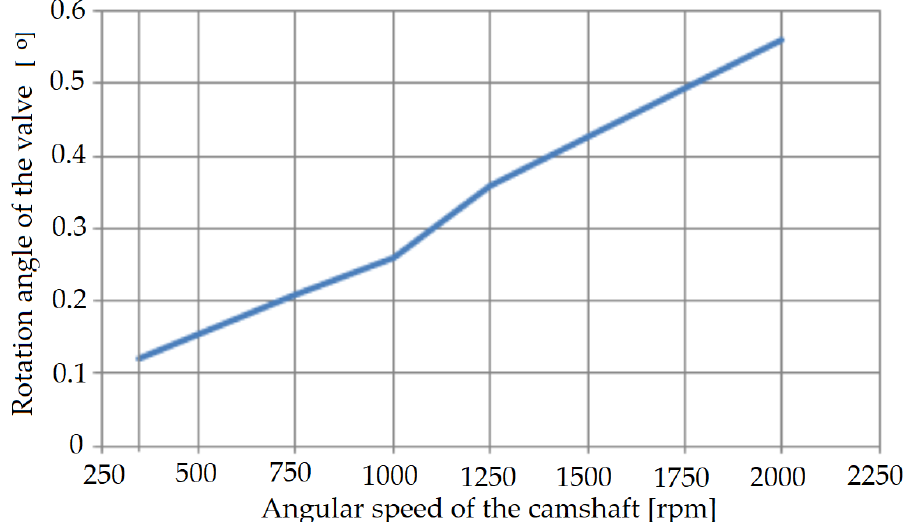
Figure 15. The influence of the camshaft speed on the rotation angle of the valve.